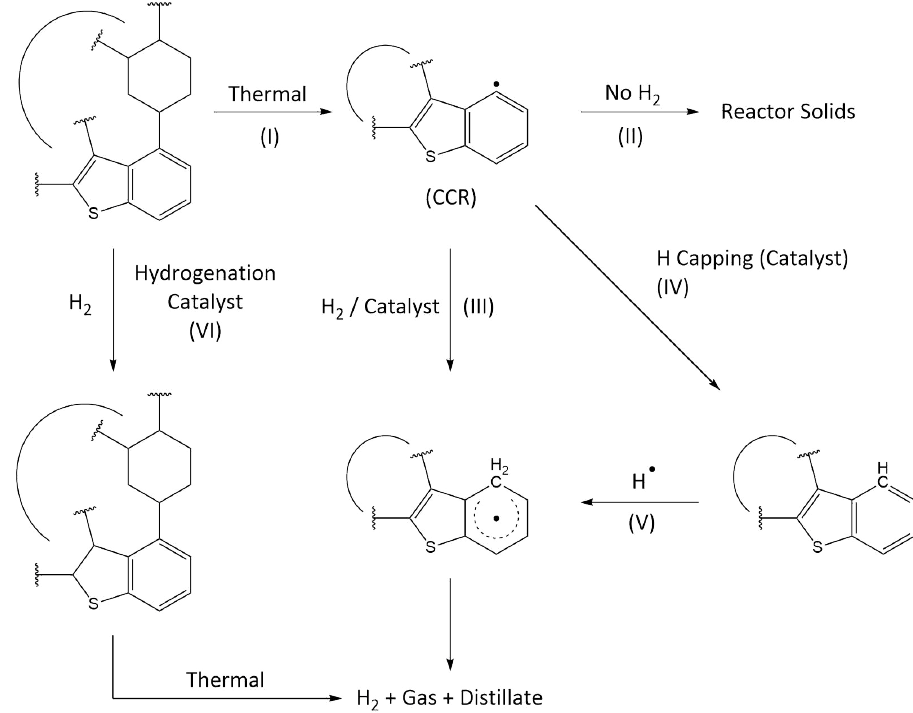
Figure 39. Proposed mechanism of hydrocracking. Figure adapted from Ref.